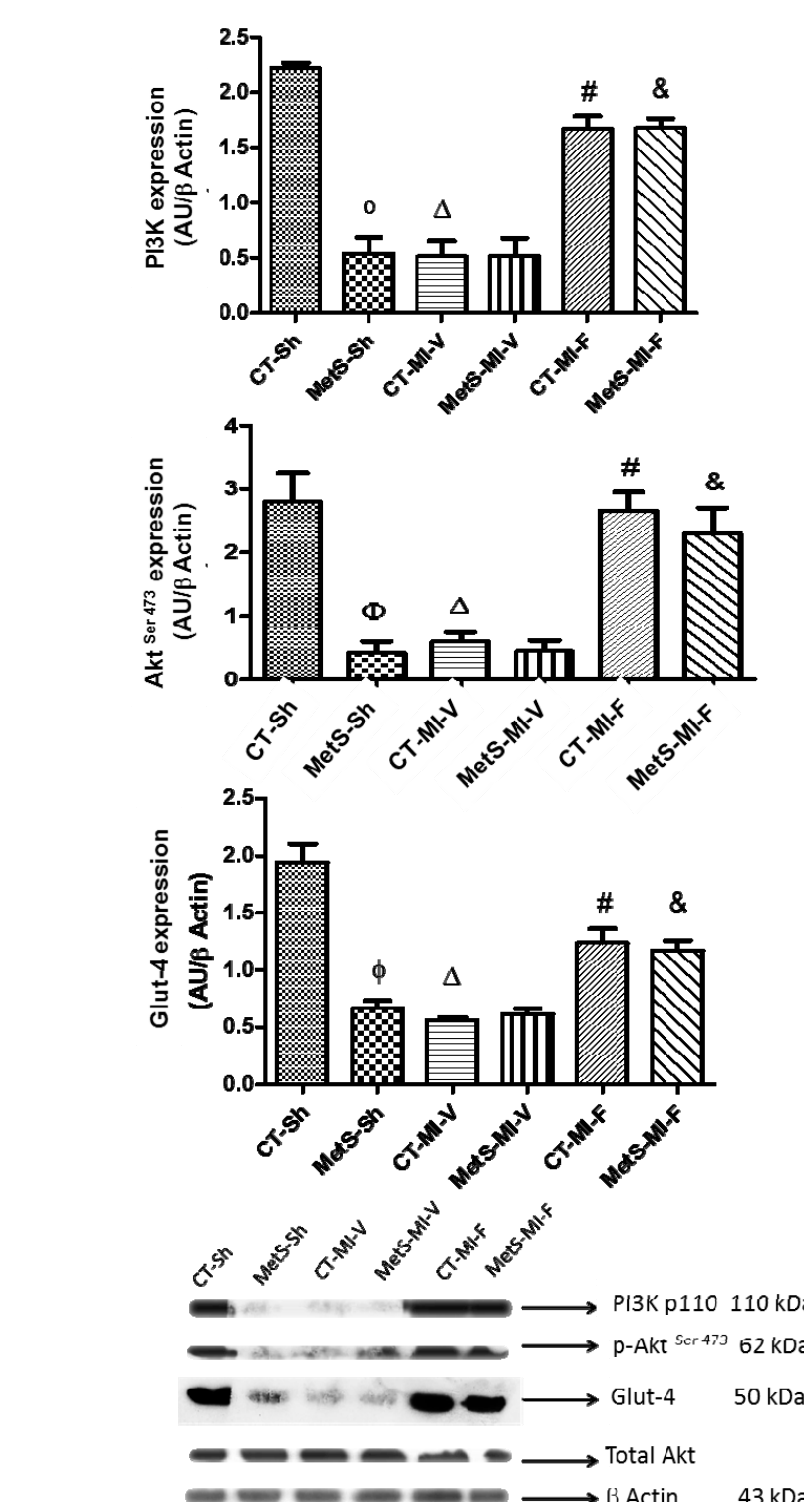
Figure 5. Fenofibrate treatment improves myocardial insulin resistance in MetS rats. Expression was evaluated by western blot in the myocardial ischemic area from sham, MI-V and MI-F groups. ( a ) PI3K p110 α subunit; ( b ) p-Akt Ser473 ; ( c ) Glut-4 protein expression; ( d ) representative immunoblot. Data represent mean ± SEM ( n = 5 per group). φ p < 0.05 vs. CT-Sh; Δ p < 0.05 vs. CT-Sh; # p < 0.05 vs. CT-MI-V; & p < 0.05 vs. MetS-MI-V. Analysis of variance-Tukey.